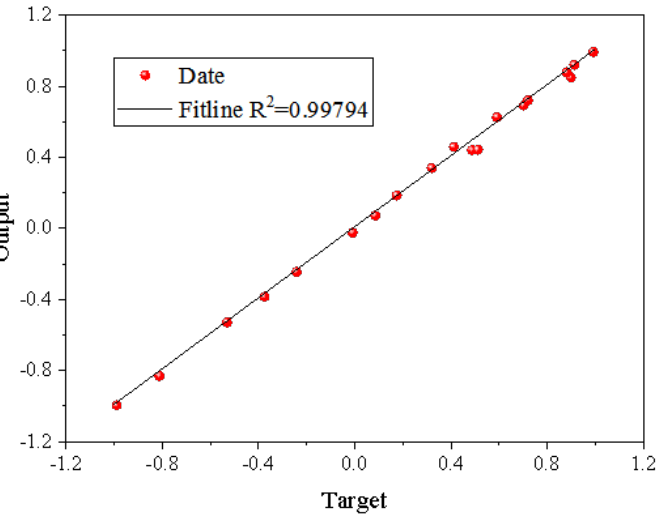
Figure 11. Fitting line of the copper recovery predicted by the BP neural network model.